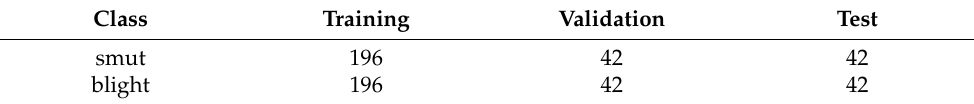
Table 2. Training Table 2. Training Dataset.